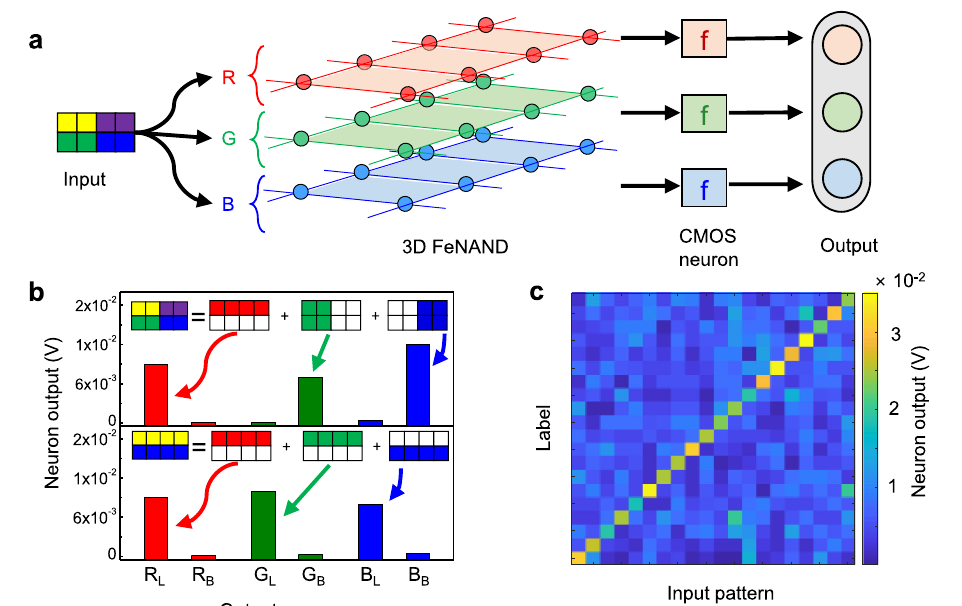
Fig. 5 | Color-mixed pattern classi fi cation using a 3D FeNAND-based neural network. a Schematic illustration of color classi fi cation using 3D FeNAND and CMOS neurons. The images fabricated by randomly adding the box and line pat- terns with red, green, or blue colors were used as test and training images. The patterns were passed through color fi lters (i.e., red, green, and blue), and the fi l- tered value was converted as the input voltage to the BLs. The output I SL was measured and used as the input for the neurons (op-amp). b Example of color-